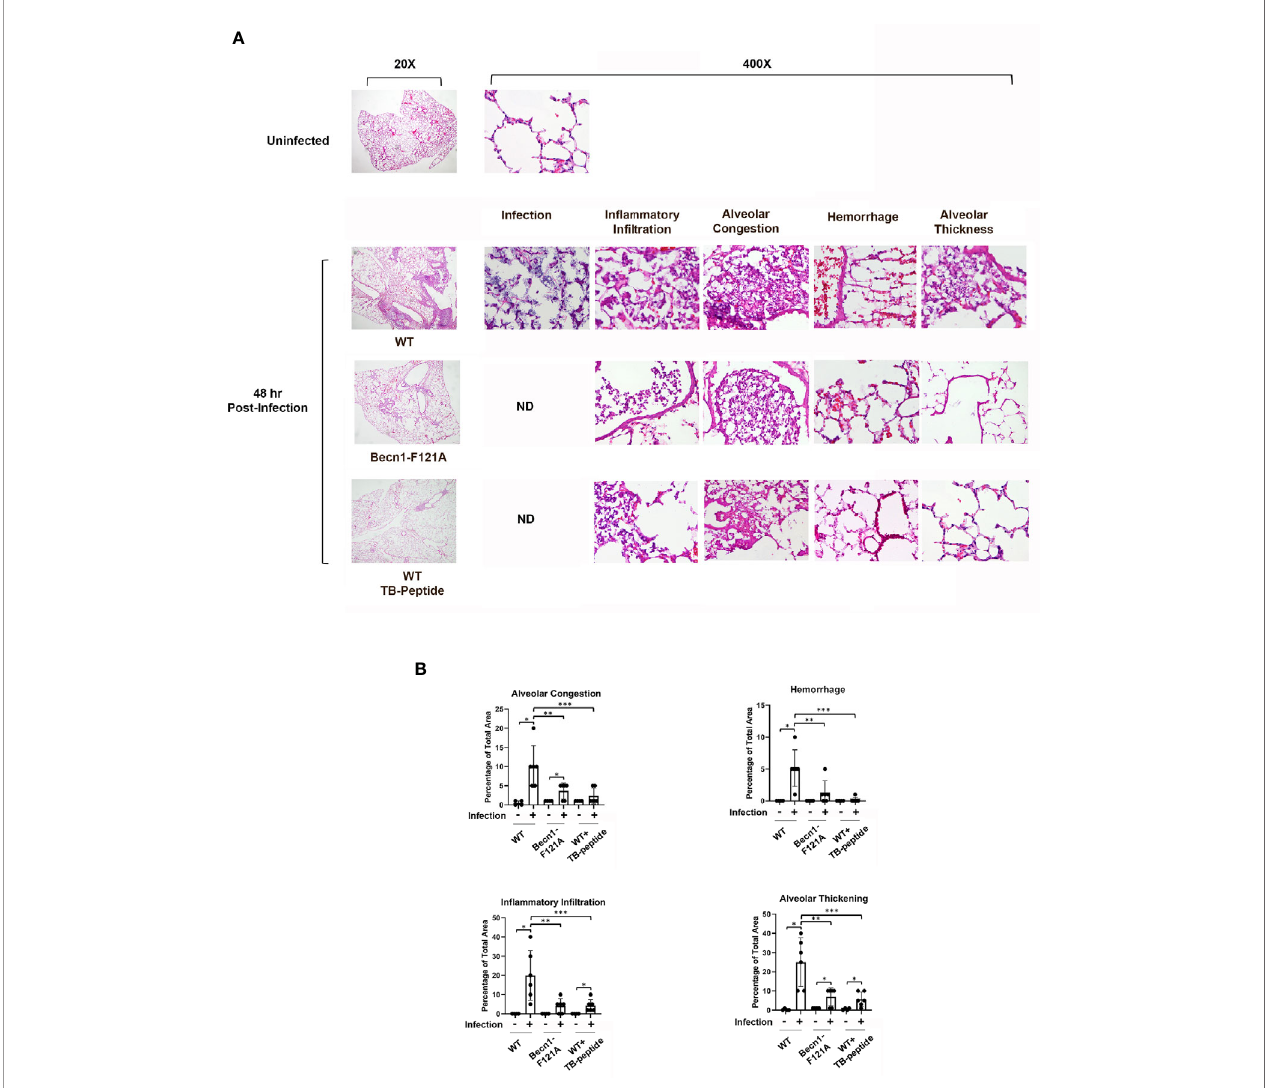
FIGURE 4 | Beclin-1 – dependent autophagy limits the progress of pulmonary pathology in pneumonia-induced sepsis. Mice of WT and Becn1 F121A/F121A were given septic infection by K. pneumoniae (3X10 7 CFU/mouse, intubation) or PBS in the uninfected group. In parallel groups, infected and uninfected WT mice were treated with TB-peptide (16.5 mg/kg, i.p.) or PBS vehicle 1 h post-infection. Lung tissue was harvested 48 h post-infection, and tissue slides were stained with Hematoxylin and Eosin (H&E). (A) H & E images of lung histology were analyzed under Olympus BX43 microscope at magni fi cations of 20X and 400X. Images are representative of n=5 per group. (B) Areas of in fl ammatory in fi ltration, alveolar congestion, alveolar thickness, and hemorrhage were quanti fi ed as percentage of total area using Image J All values are means ± SEM. Signi fi cant differences are shown as * for uninfected vs. infected, ** for WT vs . Becn1 F121A/F121A , and *** for TB-peptide treated vs . untreated ( p < 0.05, n = 5, student